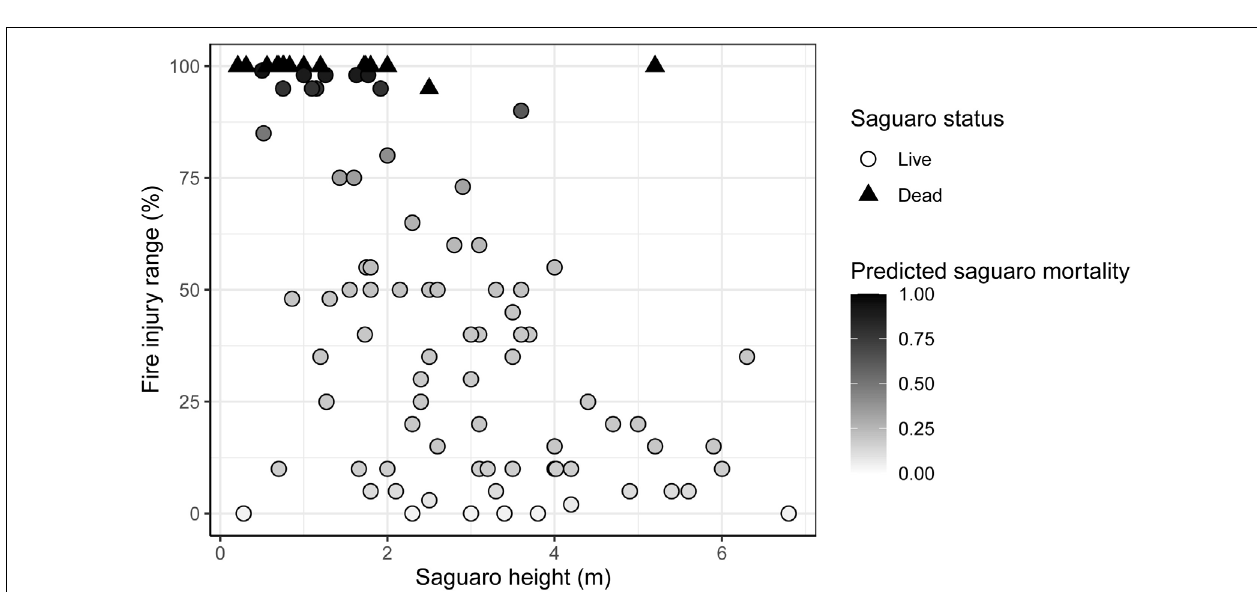
FIGURE 4 | Buffelgrass coverage by elevation. Note the elevation with most buffelgrass coverage is above the wildland-urban interface (900–950 masl), but below the Desertscrub/Semi-desert Grassland ecotone (1,200 masl).